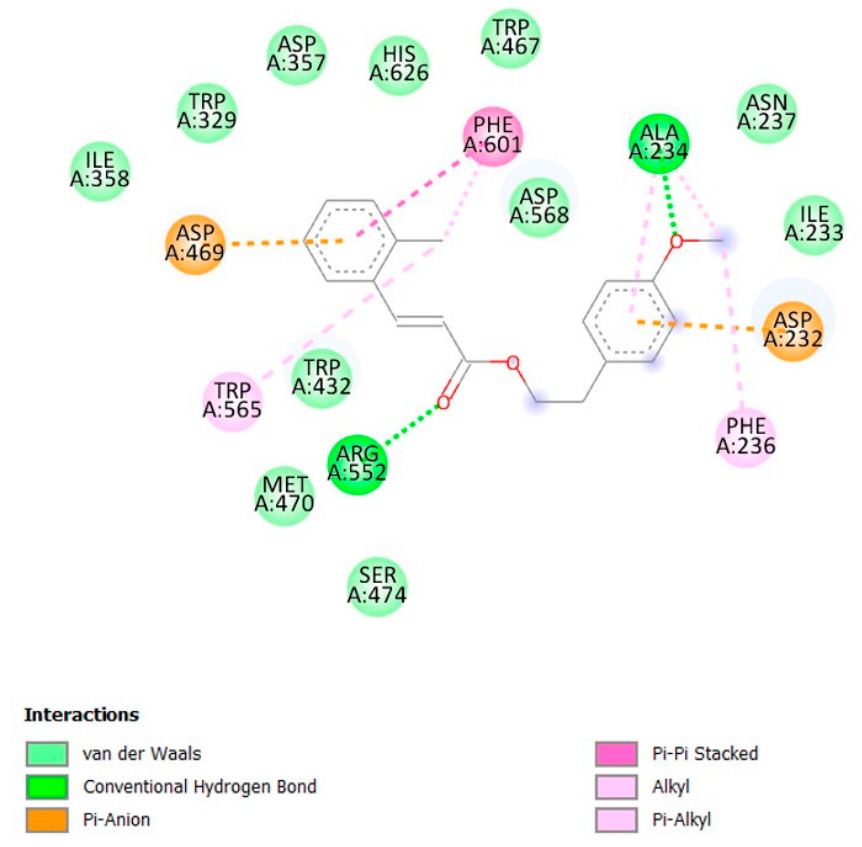
Figure 2. Ligand interaction diagram of the title compound ( 1 ) with α -glucosidase.